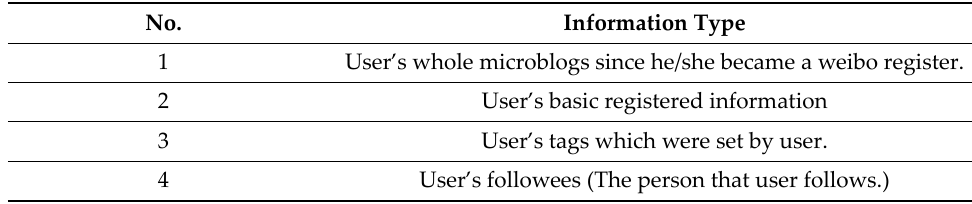
Table 2. Four types of information collected from social network platform.